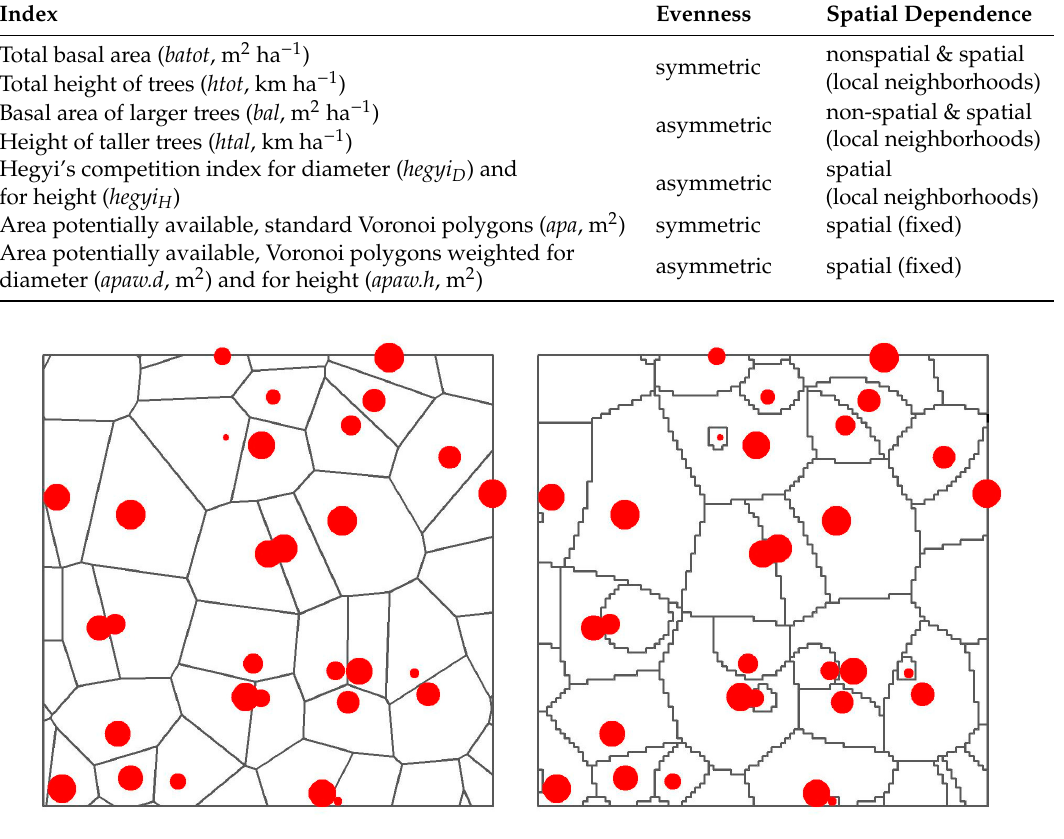
Figure 1. Examples of standard ( left ) and weighted ( right ) Voronoi polygons created starting from the same trees (red points, size proportional to their height). The standard polygon for a tree includes all the area that is closer to that tree. The weighted polygon pushes its boundaries towards neighbors with lower